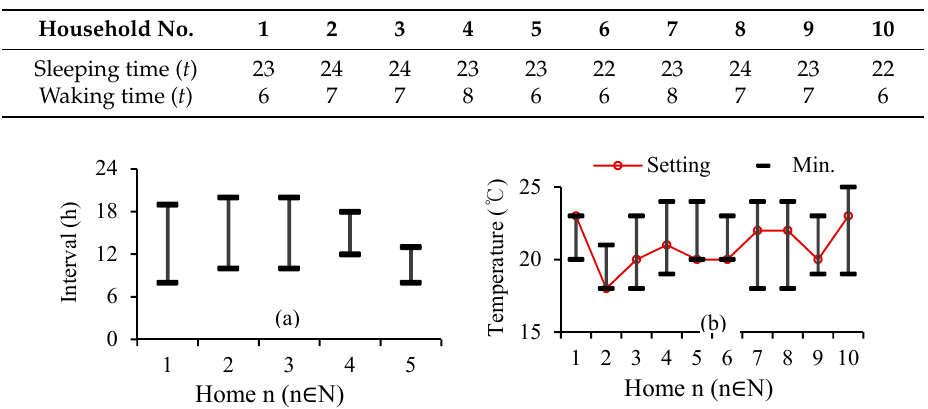
Figure 9. ( a ) Residents out stay time; and ( b ) temperature bounds. Table 3. Control parameters in greenhouse.